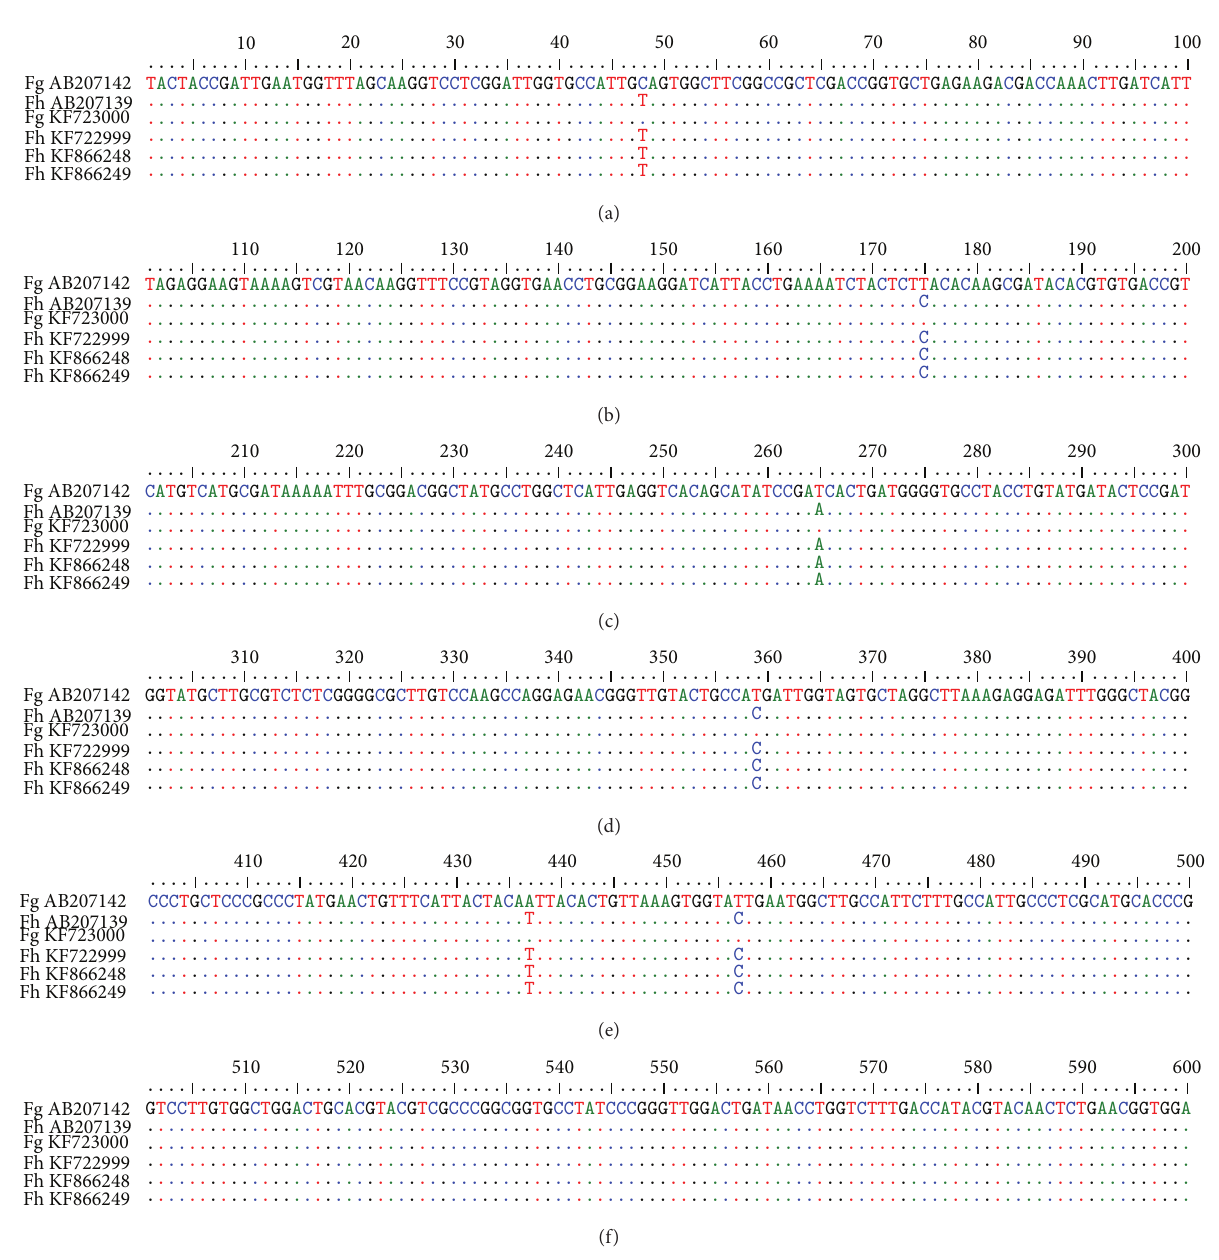
Figure 3: Alignment of ITS1 sequence of F. hepatica (AB207139) and F. gigantica (AB207142), with F. gigantica and F. hepatica of Kohgiluyeh and Boyer-Ahmad province,